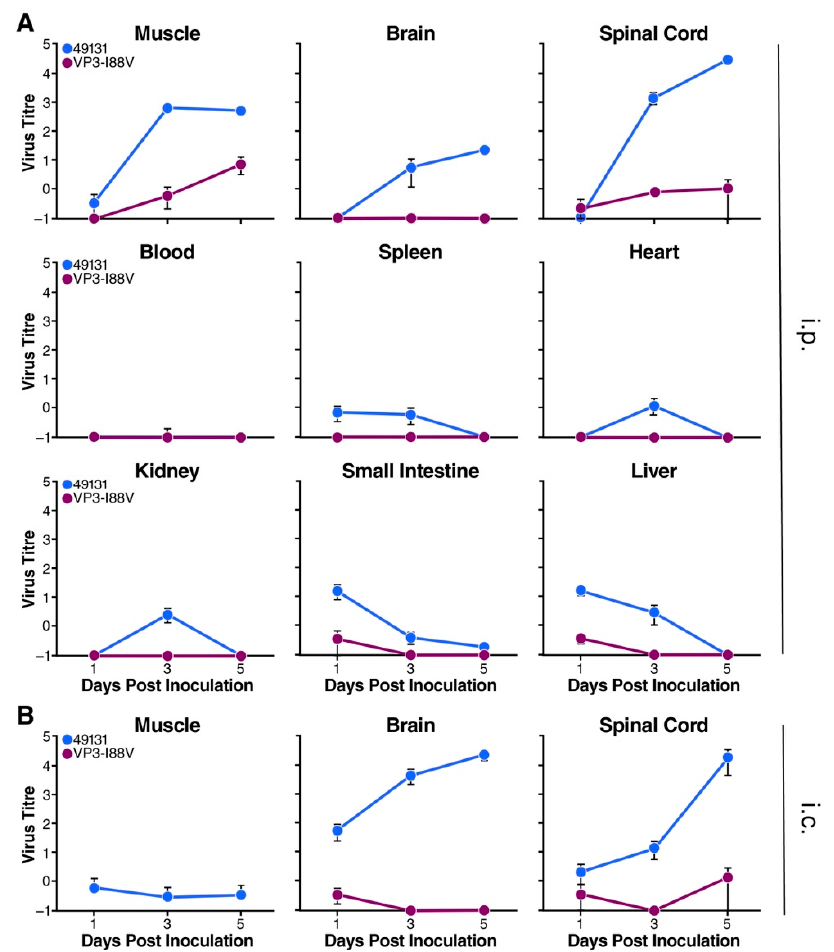
Figure 7. Tissue distribution of EV-D68 virus in Tg21 / IFNR-ko mice. Virus titers were determined by a standard TCID 50 assay and shown as log TCID 50 per milligram of tissue. Results are shown as mean ± S.E.M. ( A ) Mice of seven days old were i.p. inoculated with 1 × 10 5 TCID 50 of 49131 (shown as black) or 49131-VP3-I88V (shown as blue). At days 1, 3 and 5, tissues of three mice from each group were harvested to determine virus titers. ( B ) Mice of 5 days old were i.c. inoculated with 1 × 10 4 TCID 50 of 49131 or 49131-VP3-I88V. At days 1, 3 and 5, tissues of three mice from each group were harvested to determine virus titers.